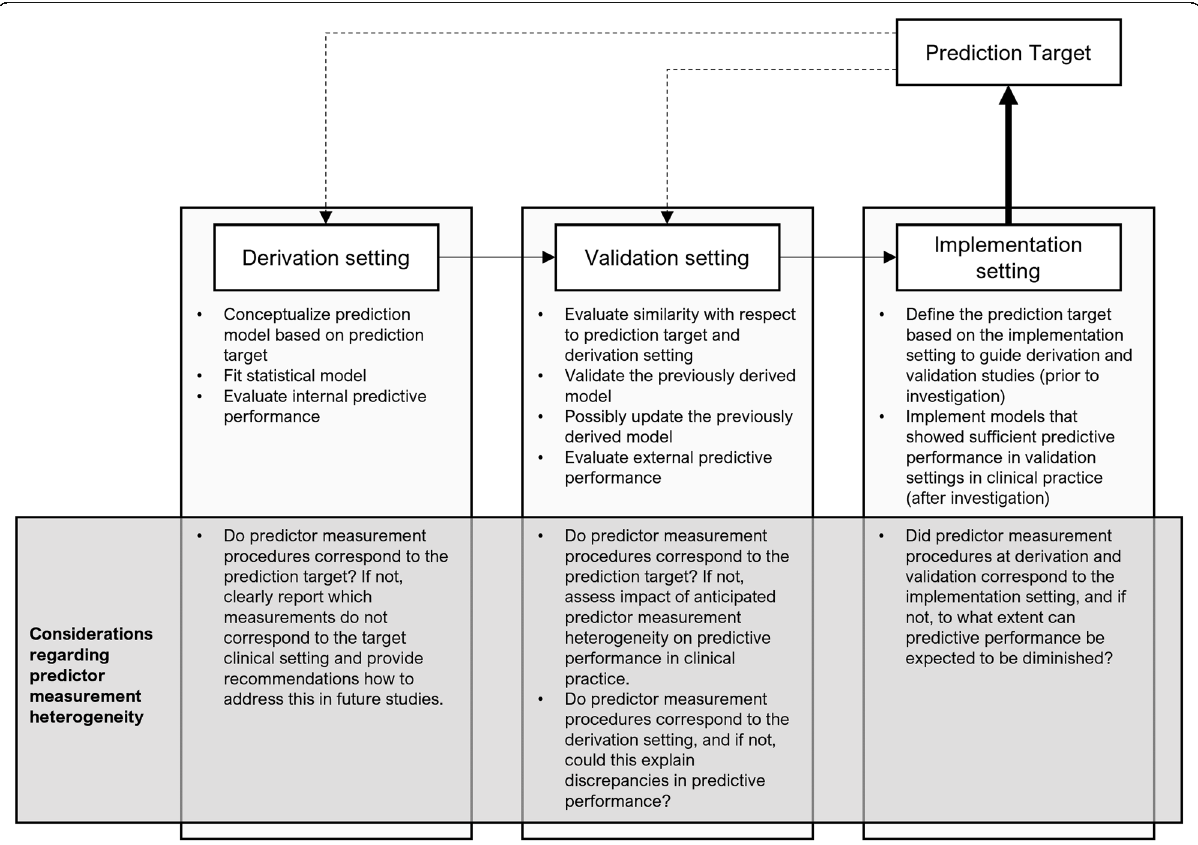
Fig. 1 An overview of the derivation, validation, and implementation setting of a prognostic model, highlighting considerations regarding predictor measurement heterogeneity. Note that “ impact analysis ” research is a phase between validation and implementation that is not addressed in this diagram. A prediction target is defined by specifying the target population, setting, outcome, (candidate) predictors, time of prediction, and prediction horizon as specifically as